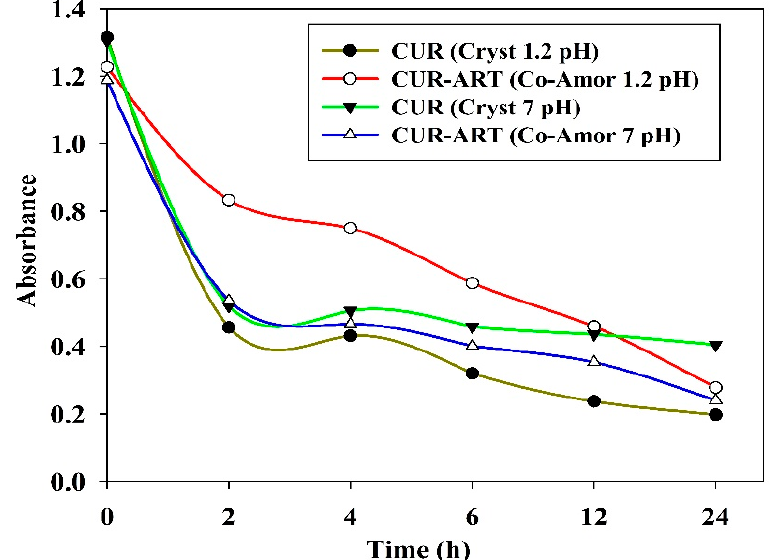
Figure 7. Supersaturation experiments of CUR and CUR-ART: UV-Vis plots of Absorbance vs. Time recorded at 420 nm peak intensity for curcumin. Note the higher concentration of curcumin from CUR-ART in acidic medium (brown trace), which indicates supersaturation in the gastric environment.